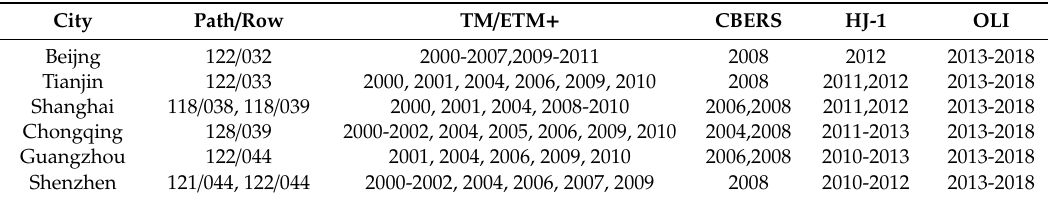
Table A1. Details of the multisource remotely sensed images.